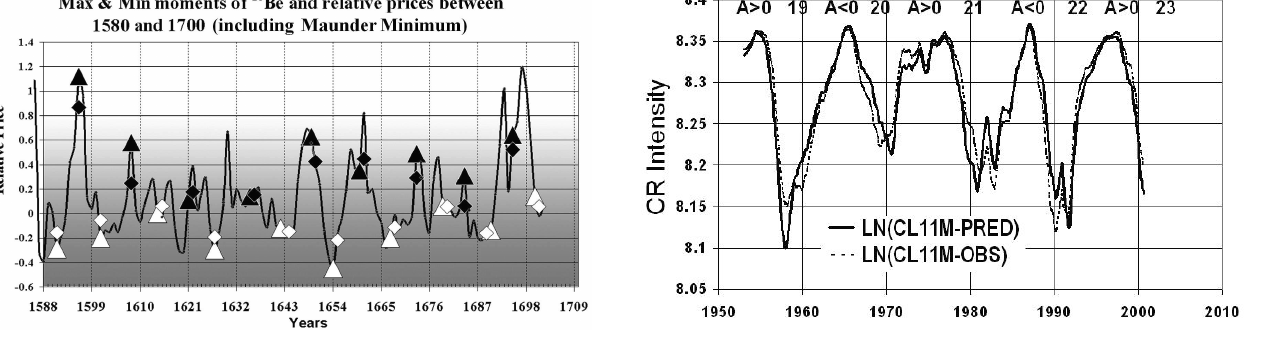
Fig. 7. Relative wheat prices at moments of minimum and maxi- mum CR intensity determined according to 10 Be data (Beer et al., 1998). White (black) diamonds show prices averaged for three-year intervals centred at moments of minimum (maximum) CR inten- sity. White (black) triangles show prices at moments of minimum (maximum) CR intensity. From Pustil’nik et al. (2003).